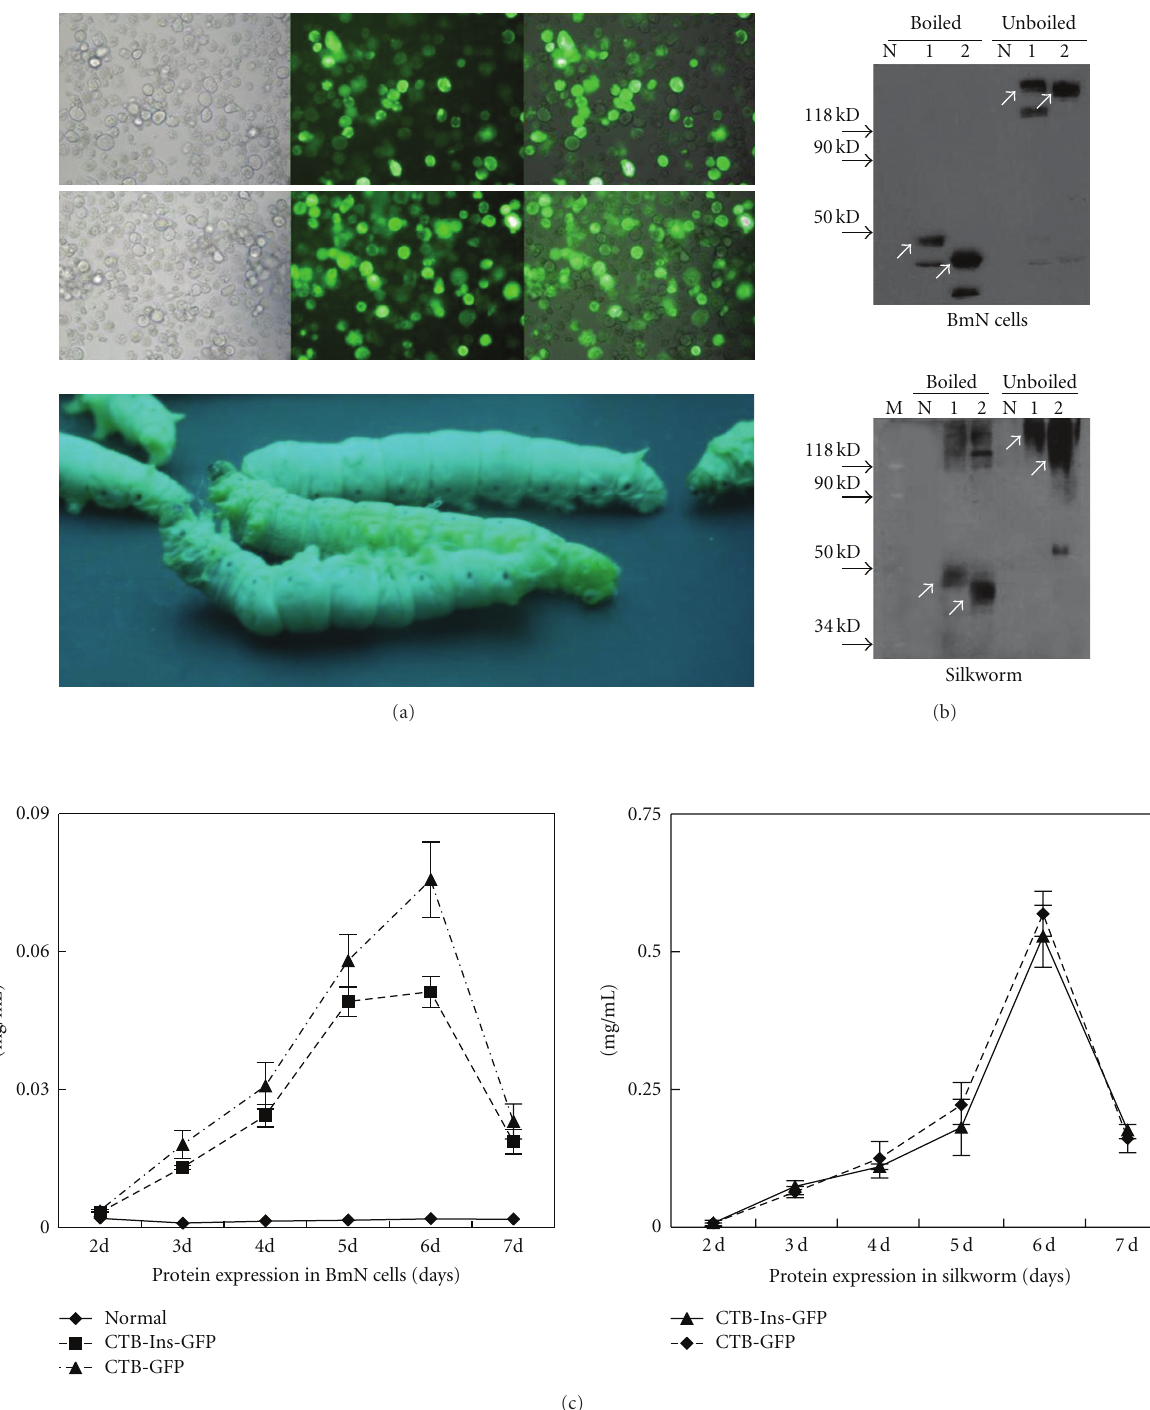
Figure 2: Identification of the expressed fusion proteins. (a) Fusion protein expression in BmN cells and silkworm B. mori fifth-instar larvae. Left to right: BmNPV CTB-GFP or BmNPV CTB-Ins-GFP 5 days after infection under normal light, blue light, and overlapped. Magnification, 200x. Lower: B. mori fifth-instar normal larvae and larvae infected with recombinant viruses 5 days after infection under ultraviolet radiation. (b) Western blot analysis of fusion protein expression. Lane N: control, lane 1: CTB-Ins-GFP protein, lane 2: